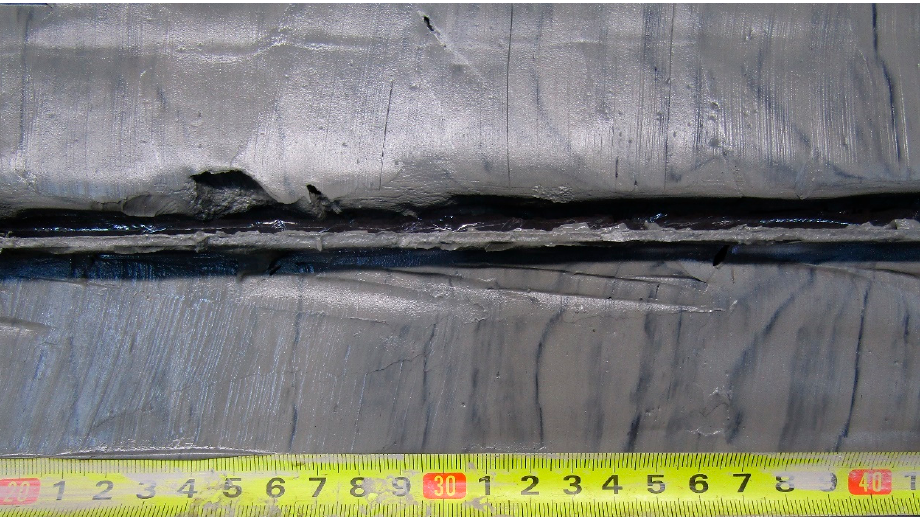
Figure 5. The lowermost part of the Holocene lacustrine sediments with clear black diagenetic layers. Lithological unit 2, core ONG-7.